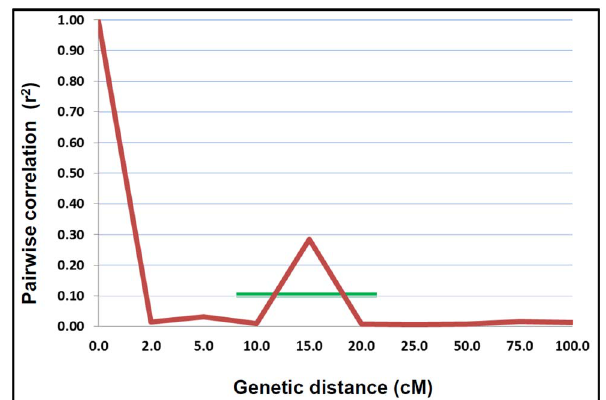
Figure 2. Linkage disequilibrium (LD) decay in the peanut ‘reference set’ based on mapped SSR marker data. The simulation trend line within 20 cM showed that the LD declined to below 0.1 within 20 cM. Hence, the estimated LD decay in the ‘reference set’ is 15.0 cM.